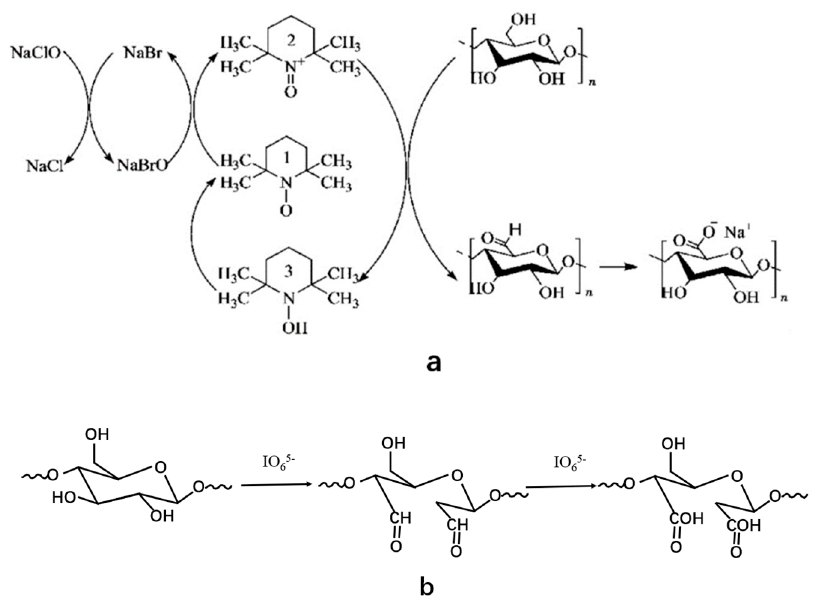
Figure 2. ( a ) TEMPO system oxidizes cellulose mechanism; ( b ) periodate oxidation mechanism. Esterified cellulose is formed by a series of condensation reactions between -OH on cellulose and acid, acid anhydride and acid halide, etc. The traditional industrial production of cellulose esters basically adopts a solid–liquid two-phase two-step process for lack of effective cellulose solvents: firstly, fully substituted cellulose esters are obtained through solid–liquid two-phase heterogeneous acylation, and then cellulose esters with appropriate degree of substitution is obtained by acid catalytic hydrolysis